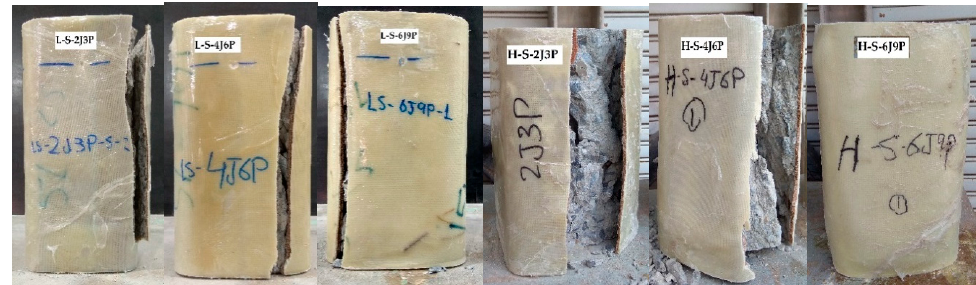
Figure 9. Failure modes of low- and high-strength square columns.